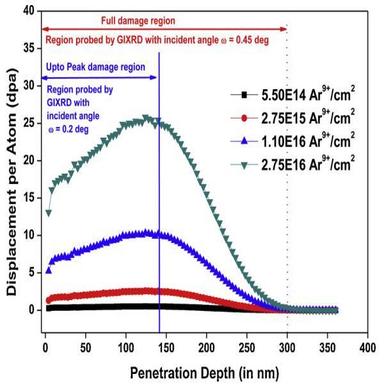
Displacement per atom (dpa) as a function of depth simulated from SRIM 2013 at different dose. The vertical lines mark the maximum depth from which the information is obtained using Grazing incidence X-ray diffraction (two different incident angles (ω) were used to cover the peak damage region (0.2°) and the full damage region (0.45°)).